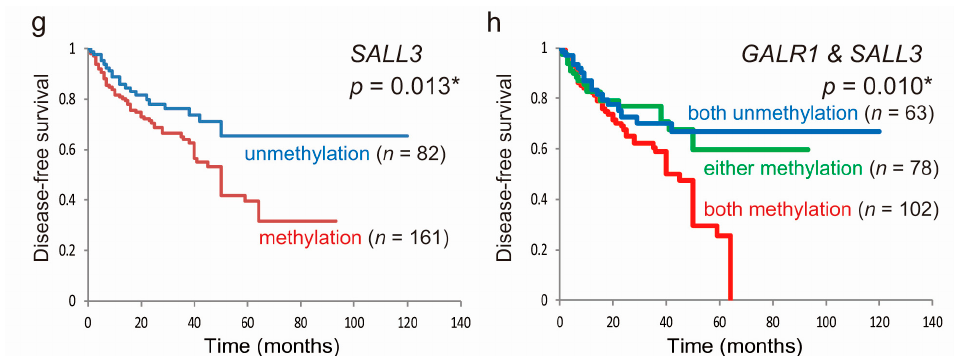
Figure 2. Kaplan–Meier survival curves for the 243 patients with HNSCC according to the methylation status of the seven target genes. Disease-free survival based on ( a ) ATP9B, ( b ) GALR1, ( c ) HSBP1L1, ( d ) KCNG2, ( e ) NFATC1, ( f ) PARD6G, and ( g ) SALL3 methylation; methylated (red lines) and unmethylated (blue lines) cases are shown; ( h ) joint analysis of GALR1 and SALL3 genes. blue line: patients with both unmethylated genes; green line: patients with either methylated gene; red line: patients with both methylated genes. A probability of <0.05 (* p < 0.05) was considered a statistically significant difference.